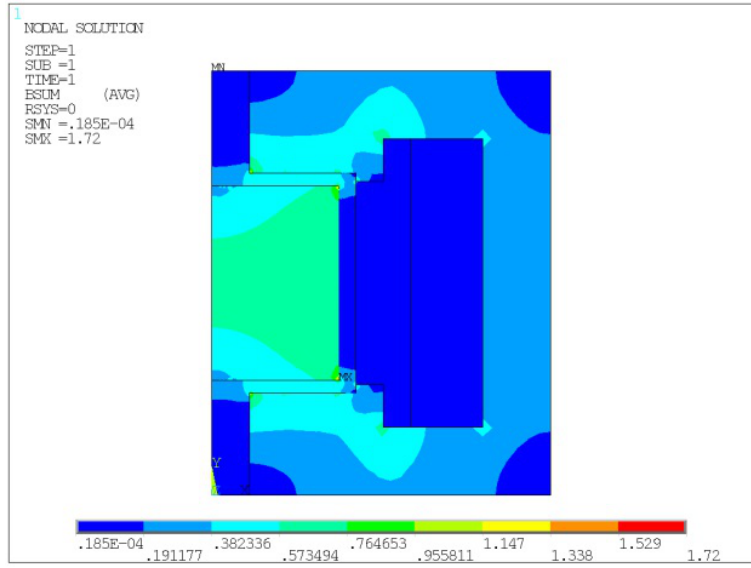
Figure 10. Contour of magnetic flux density.